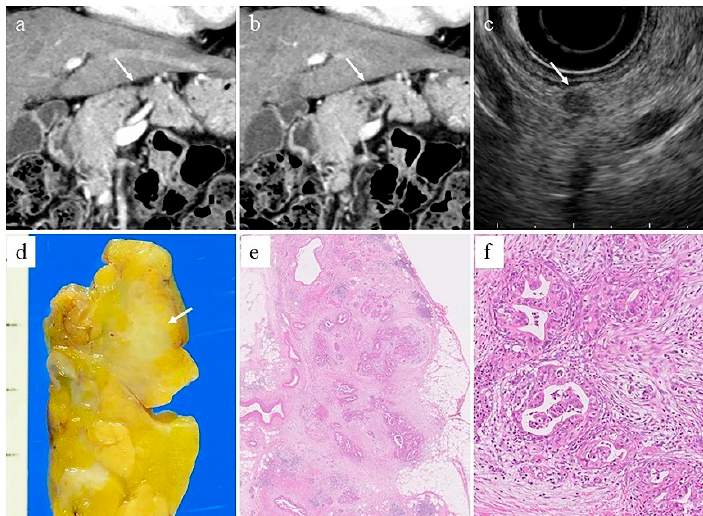
Figure 1. A 68-year-old woman with small pancreatic cancer. ( a,b ) Computed tomography shows parenchymal atrophy of the pancreatic body (arrow), but no obvious mass. ( c ) Endoscopic ultrasonography shows a well-defined, irregular hypoechoic mass with a diameter of 8 mm in the pancreatic body (arrow). ( d ) Surgically resected specimen shows a grayish-white solid mass (arrow). ( e ) Loupe image of the mass. ( f ) Moderately differentiated tubular adenocarcinoma (magnification: ×100).